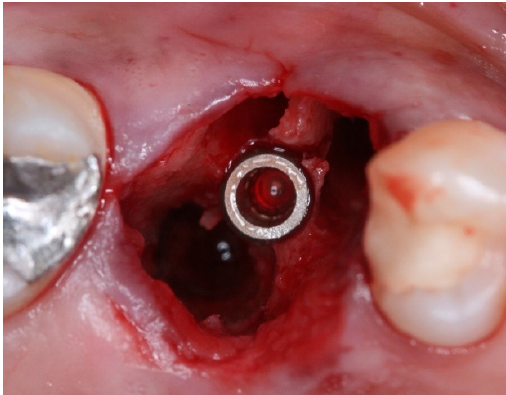
Figure 14. Intra-oral oclusal view of #16 after morse tapper implant placement.